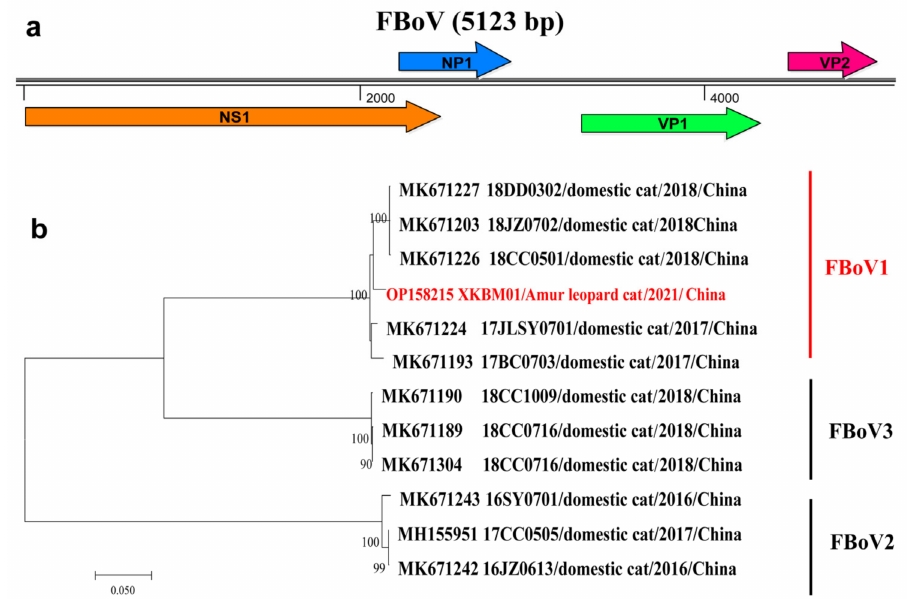
Figure 3. Genomic structure ( a ) and phylogenetic relationship ( b ) (based on NS1 gene) of FBoV XKBM01, which is highlighted in red in the phylogenetic tree. Bootstrap values of ≥ 70 are shown next to